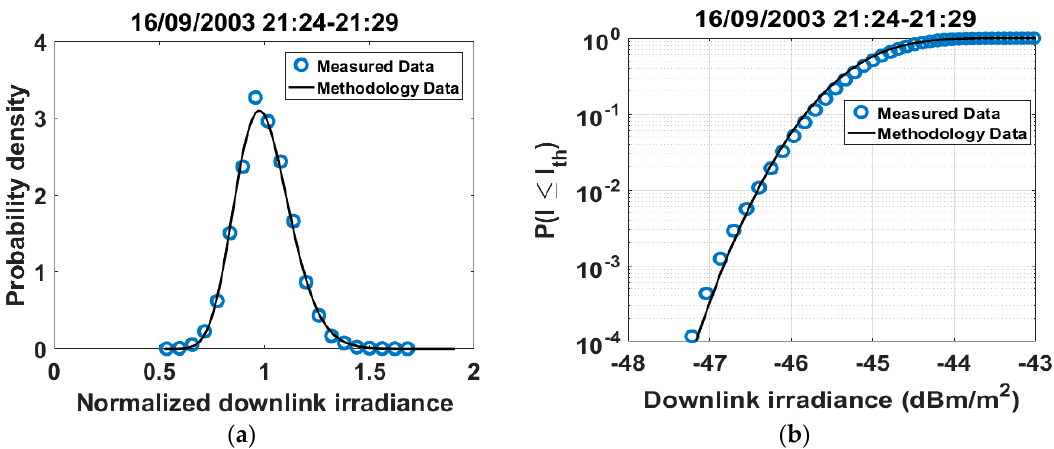
Figure 6. First order irradiance statistics validation for session on 16 / 09 / 2003 21:10. ( a ) Normalized PDF of measured data vs. Normalized PDF of generated data; ( b ) CDF of measured data vs. CDF of generated data.